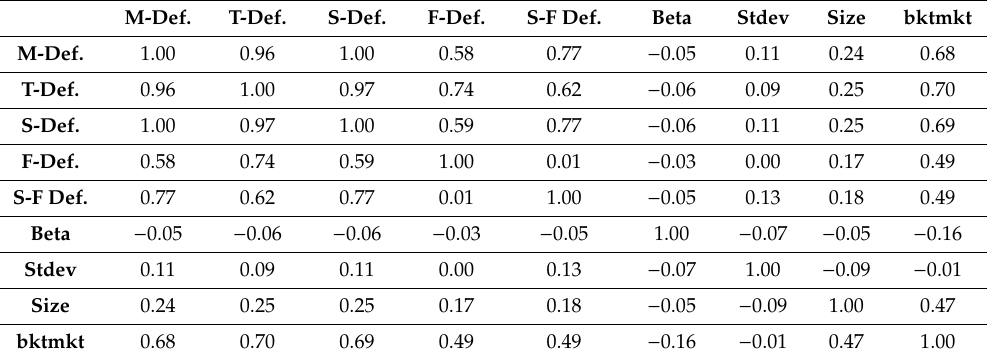
Table 1. This table shows pairwise correlations between di ff erent measures of default probability, beta, size, and book-to-market ratio, for the period July 1963 to December 2013. M-Def. is Merton’s default probability, T-Def is the total default probability from Geske’s model, S-Def. is the short-term default probability, F-Def. is the forward default probability, S-F Def. is the short-term minus forward default probability from Geske’s model. Beta is the CAPM beta, size is the market value of equity, and bktmkt is the book-to-market